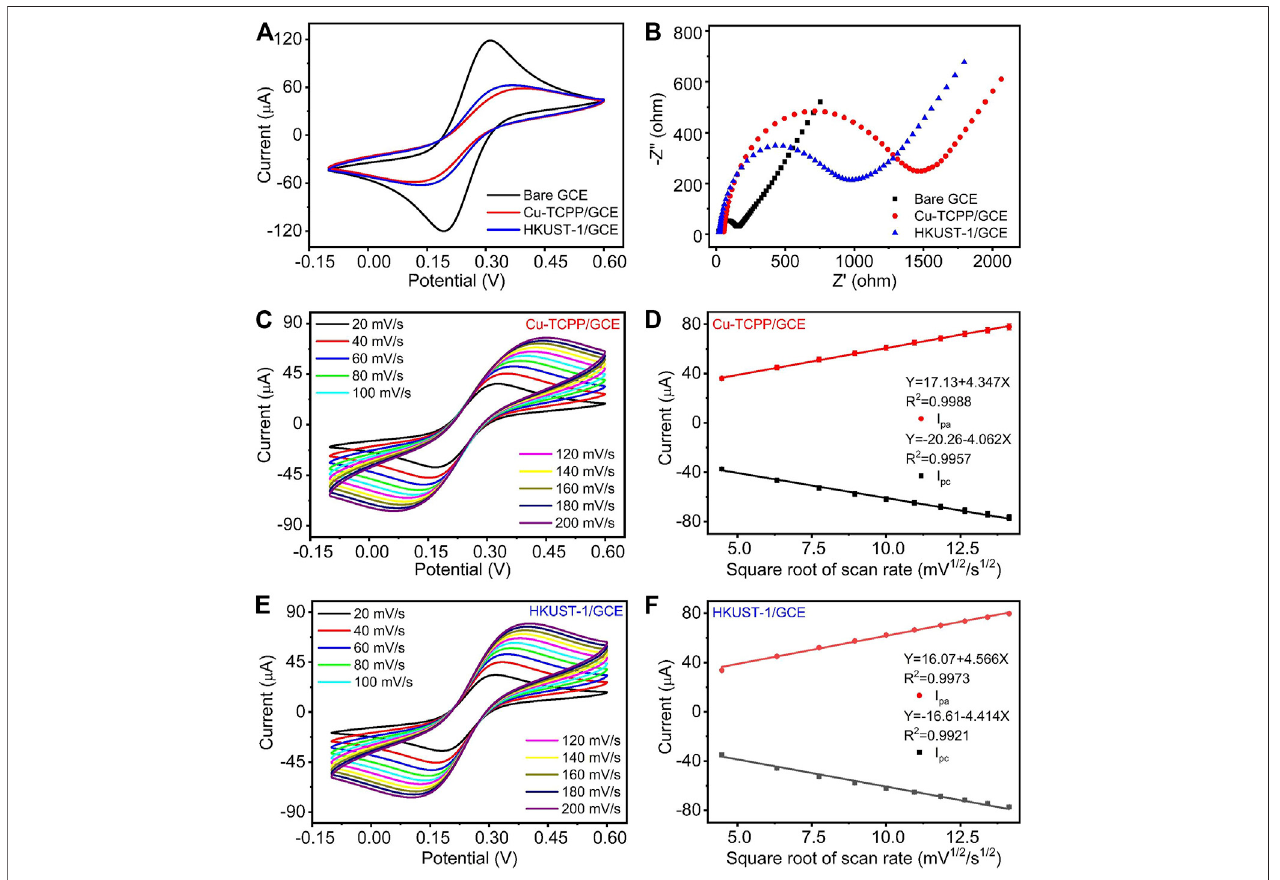
FIGURE 3 | (A, B) CV curves and EIS curves of GCE, Cu-TCPP/GCE, and HKUST-1/GCE. (C) CV curves of Cu-TCPP/GCE in the aqueous solution containing 5 mMK 3 [Fe(CN) 6 ]/K 4 [Fe(CN) 6 ]and0.5 MKClwithdifferentscanrates(20,40,60,80,100,120,140,160,180,and200 mV/s). (D) Thelinearrelationshipsbetweenthe electrocatalytic peak current with a square root of the scan rate. (E) CV curves obtained by HKUST-1/GCE with different scan rates. (F) The linear fi tting program of the reduction peak current with a square root of the scan rate obtained by